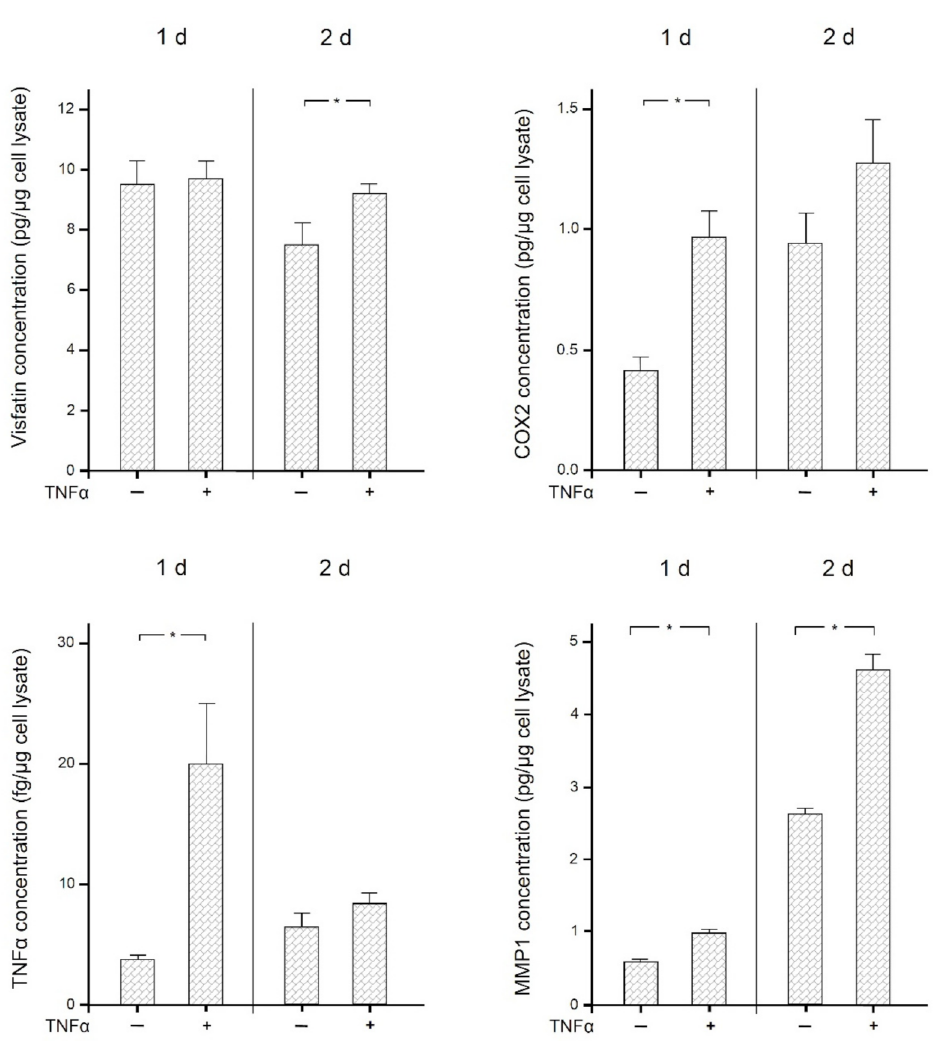
Figure 7. Visfatin, COX2, TNF α , and MMP-1 protein levels in the presence and absence of TNF α (1 ng/mL) at 1 d and 2 d, analyzed by ELISA. Mean ± SEM, n = 18/group. * significant ( p < 0.05) difference between